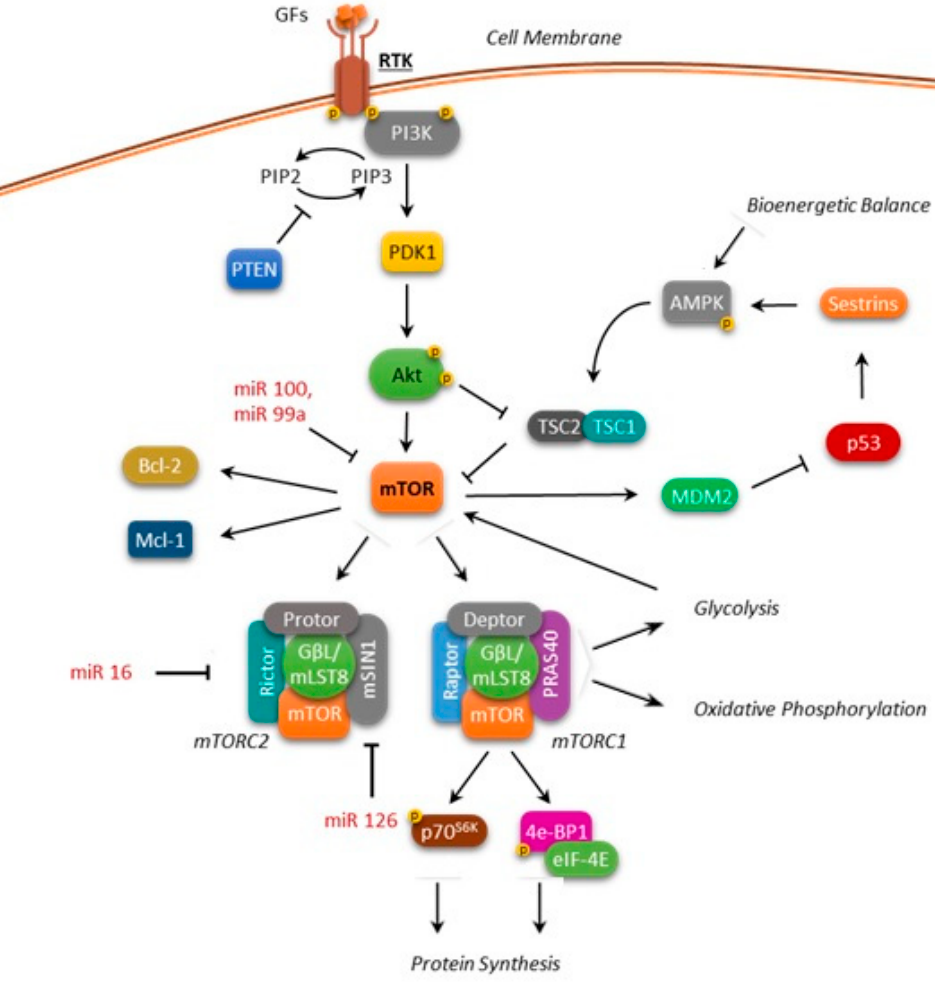
Figure 1. Overview of the mTOR regulation network. Arrows: positive interaction; T-bars: inhibition.